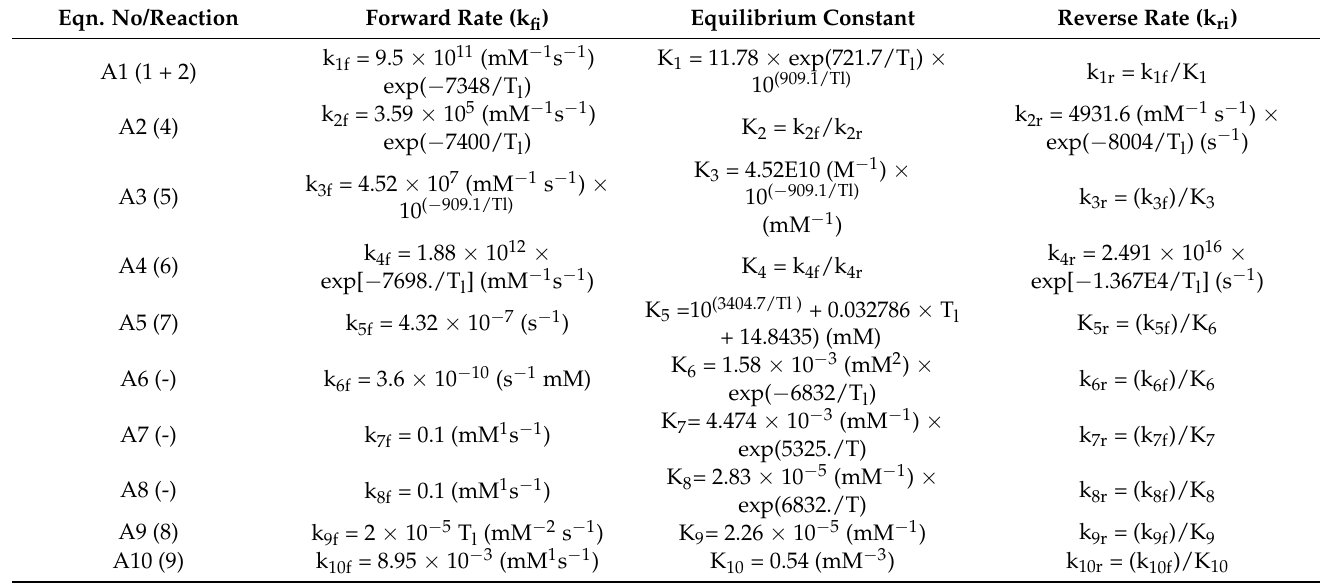
Table A2. Kinetic information used in solving the proposed reaction model.